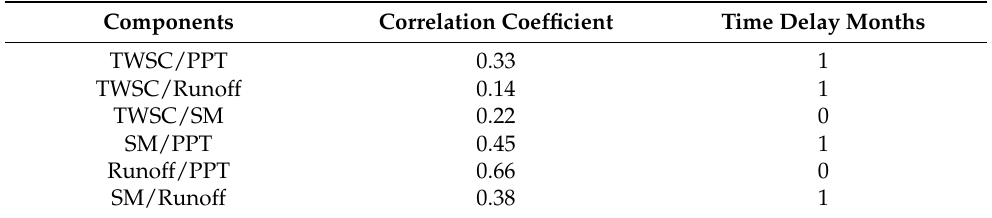
Table 4. The correlation coefficients and time delay months between TWSC, PPT, SM, and runoff anomaly in the UY (these results have passed the 95% confidence level).